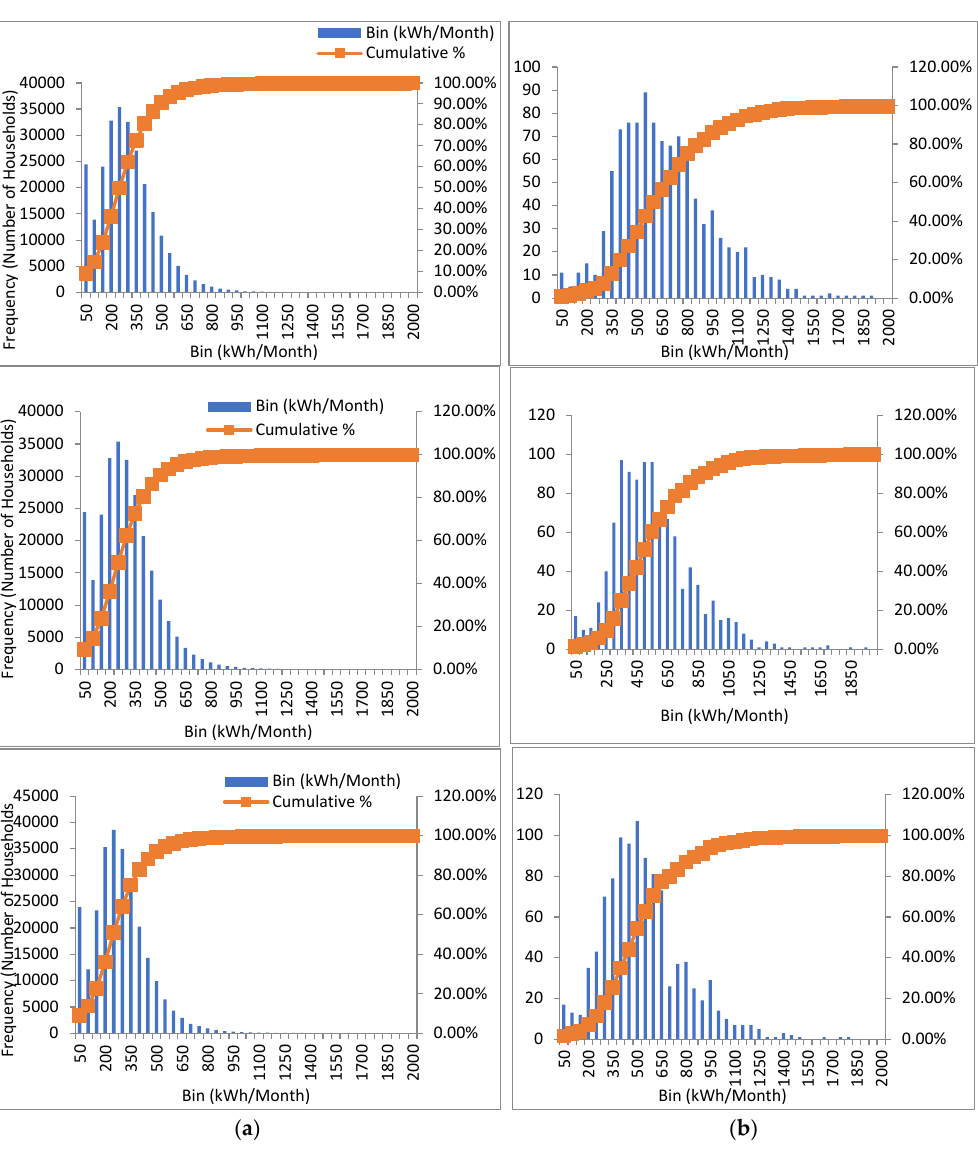
Figure 9. Energy consumption in March, April, and May: ( a ) Ordinary households; and ( b ) Subsidized households.